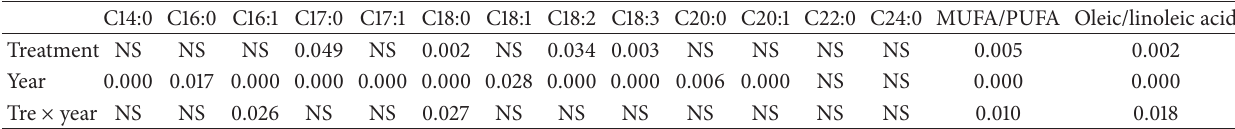
Table 4: MANOVA (prob. > 𝐹 ) of oil fatty acids (%) as a function of treatment and year ( 𝑛 = 3